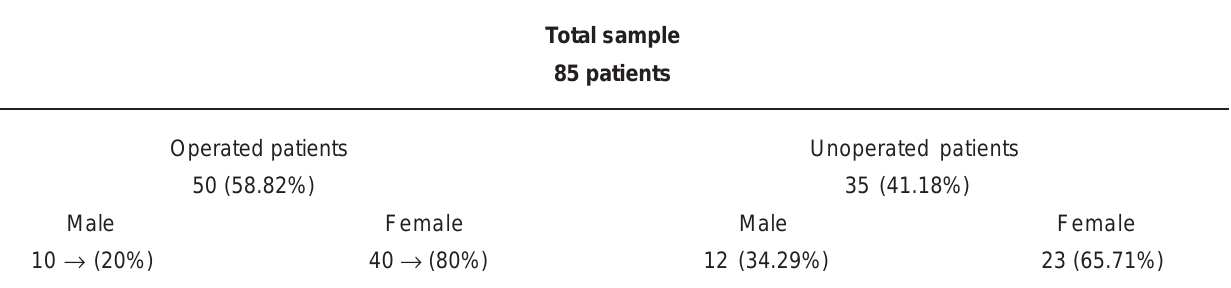
TABLE 1- Compilation of the studied population: patients with complete and incomplete cleft palate distributed according to gender and operated or unoperated conditions